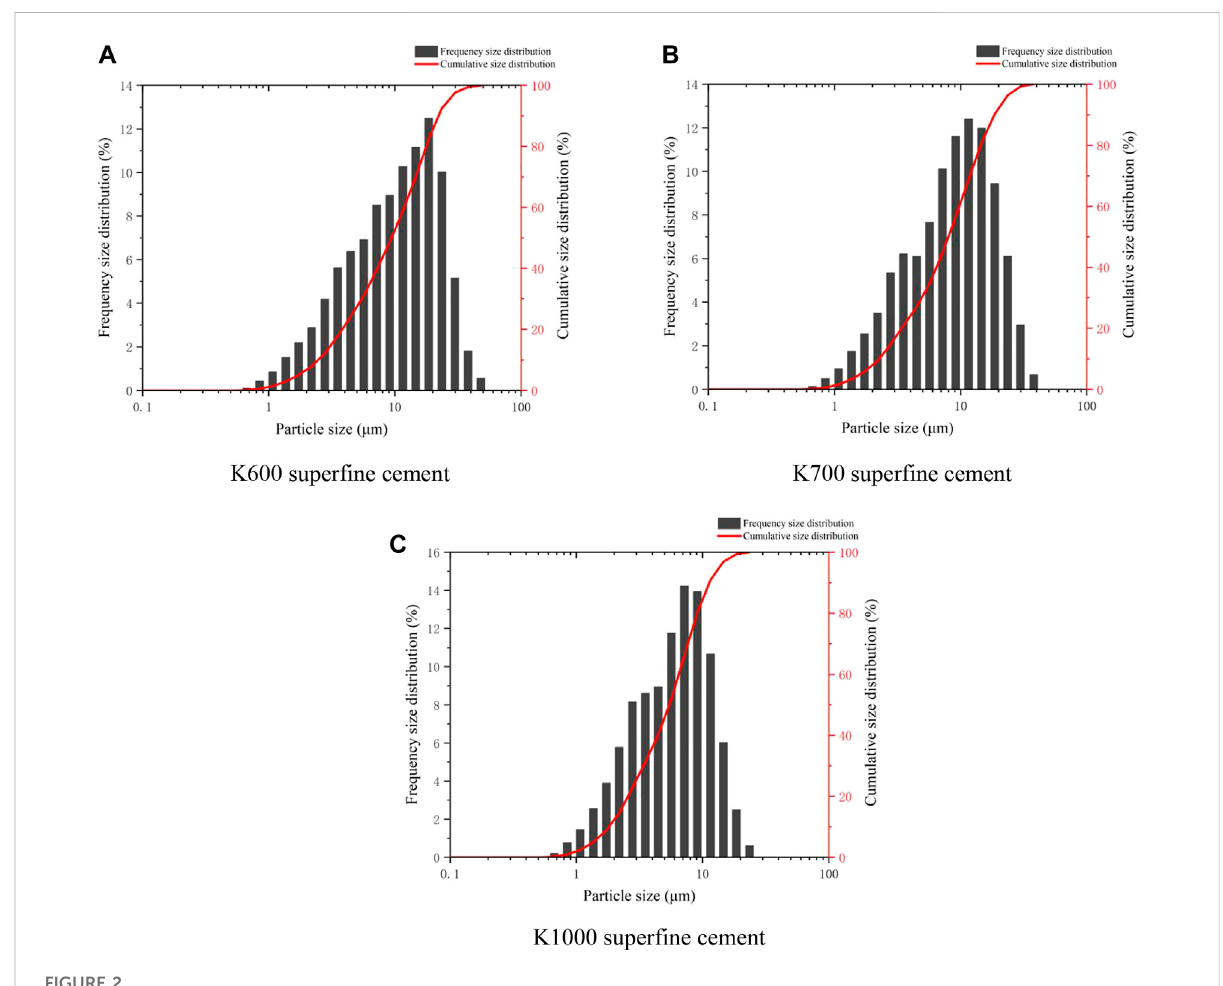
FIGURE 2 The particle size distribution of super fi ne